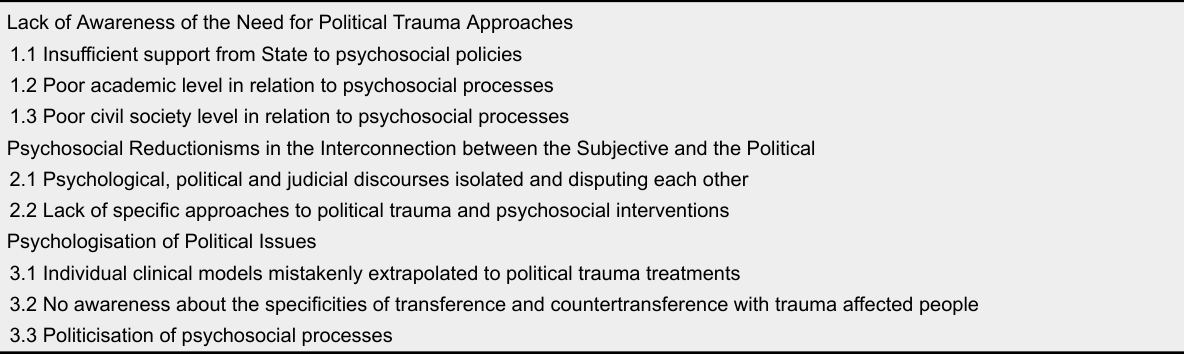
Study Results: Categories and Subcategories Concerning Secondary Victimization on Psychosocial Interventions for Political Trauma Victims in